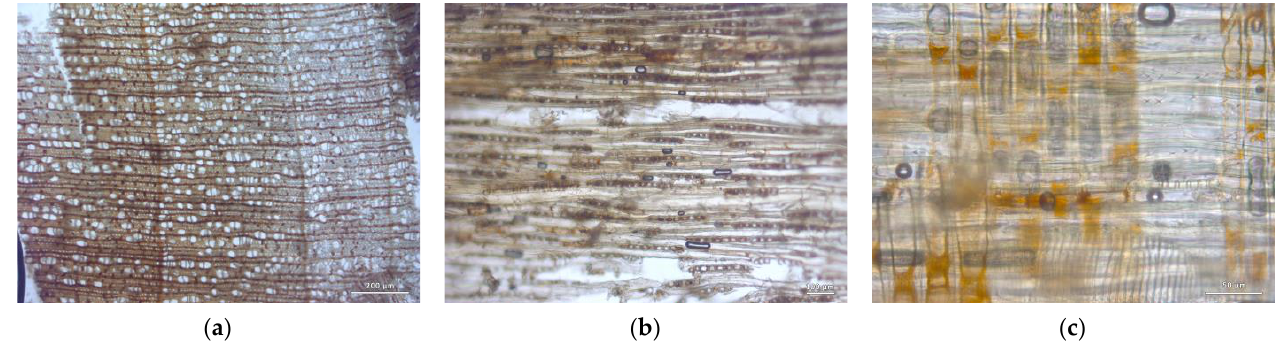
Figure 16. Characteristic sections of sample LE1 identified as belonging to the Alnus genus: ( a ) Cross-section; ( b ) Tangential section; ( c ) Radial section.